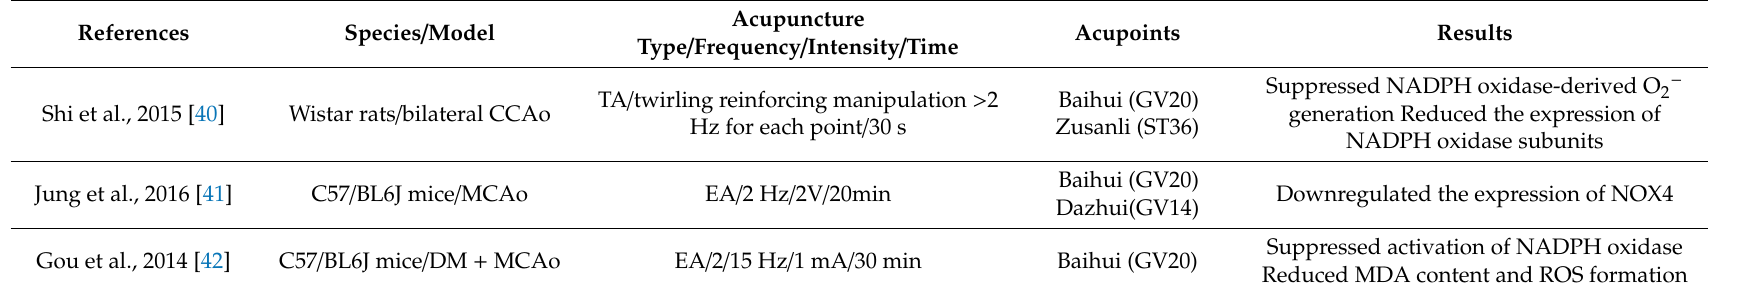
Table 2. Acupuncture regulates the generation of ROS.